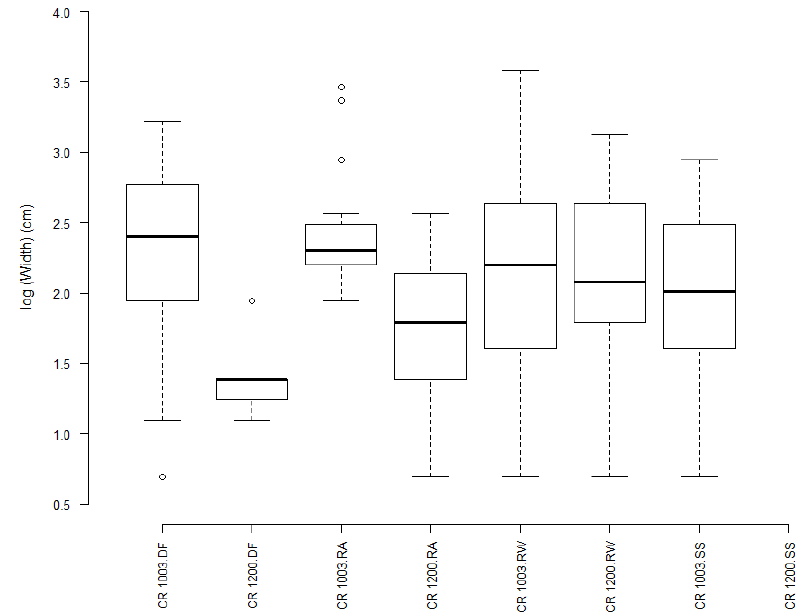
Figure 3. Scar width difference among species in CR 1200 and CR 1003 (RW: redwood, DF: Douglas-fir, RA: red alder, and SS: Sitka spruce). Each name on horizontal axes is composed of unit and species.